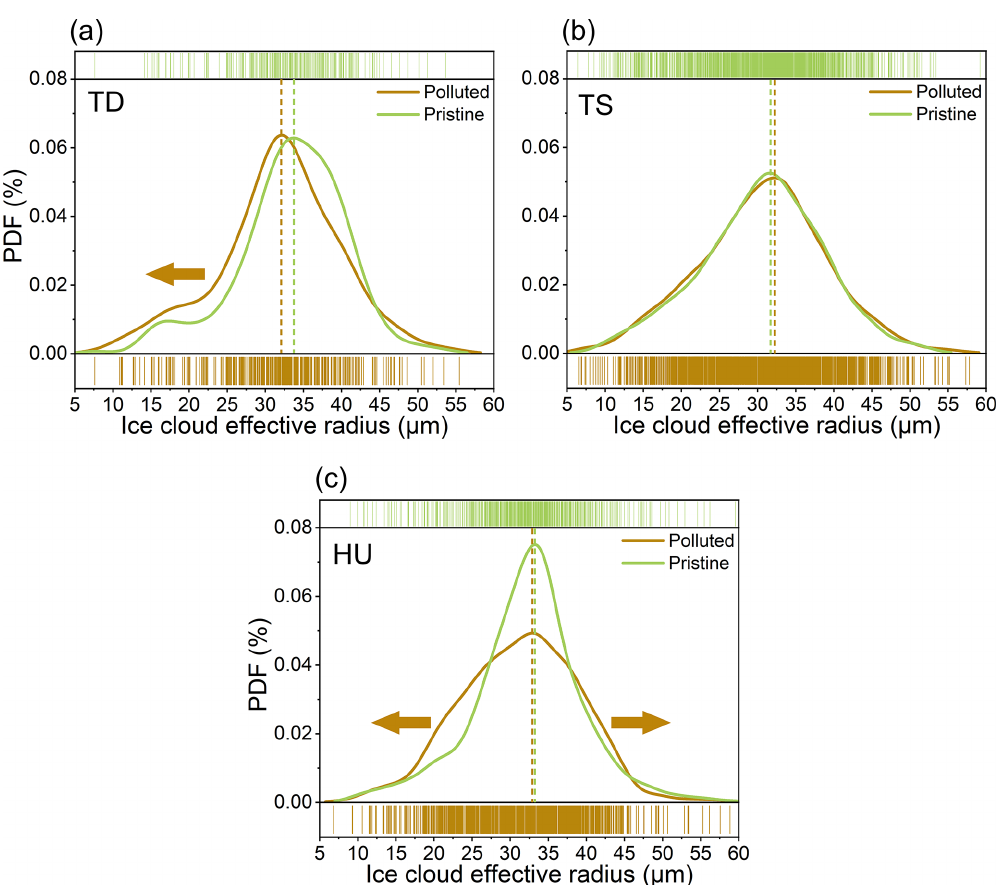
Figure 10. The PDFs of CER i under pristine and polluted conditions by different TC intensities. (a) TD, (b) TS, and (c) HU. The dashed lines indicate the peak perpendicular lines of the PDFs.